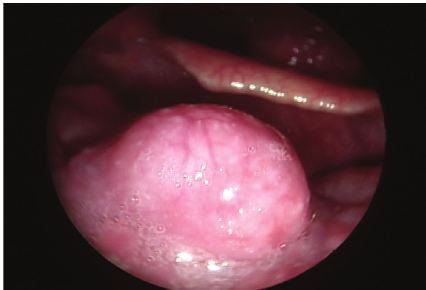
Figure 1: Laryngoscopy of a 54-year-old man with an incidentally detected mass at the tongue base. The tumor was 1cm in size, and the overlying mucosa was not invaded.